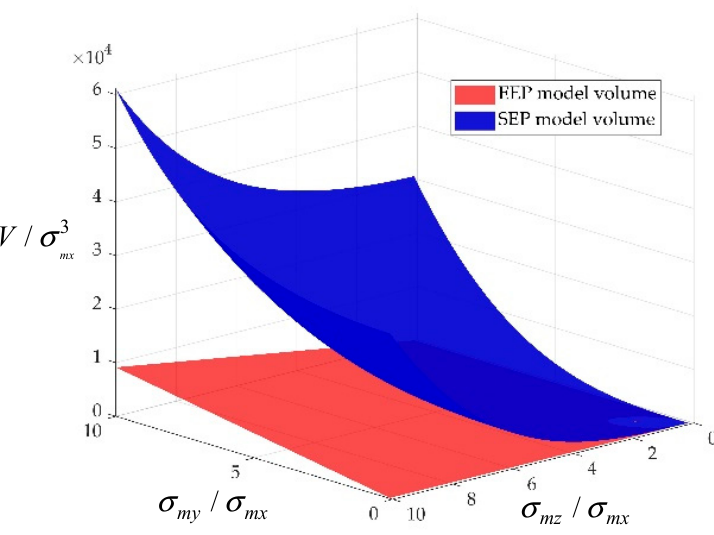
Figure 6. Comparison between SEP volume and EEP model volume. At the same time, the projection of the EEP model and SEP model in the XOY, XOZ, and YOZ planes are compared, respectively. As shown in Figures 7–9, the EEP model more accurately represents the difference of position error variance of FMS position estimation in every direction, and realizes the accurate evaluation of the three-dimensional direction of position